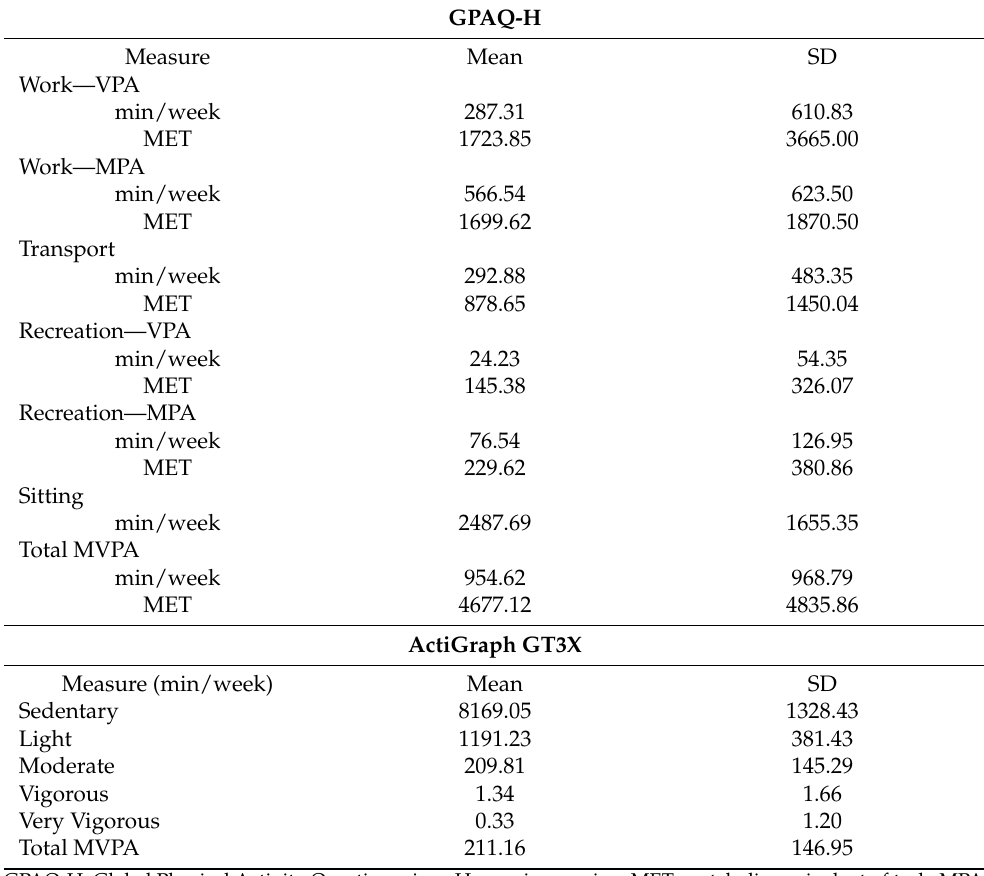
Table 3. Pretreatment physical activity characteristics of women undergoing IVF/ICSI by GPAQ-H questionnaires and ActiGraph GT3X data (N = 26).